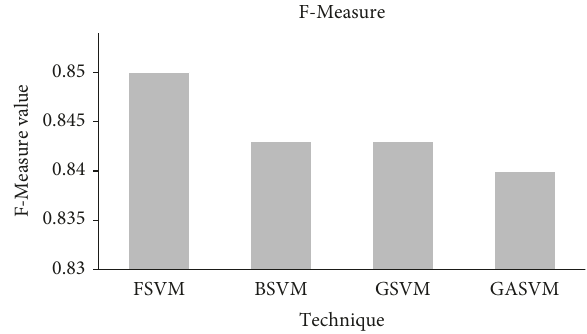
Figure 3: f -measure performance of four search algorithms. The f - measure is calculated by weighing the harmonic means of precision and recall equally. It allows a model to be evaluated with a single score that accounts for both accuracy and recall, which is valuable for comparing models and summarizing their performance.